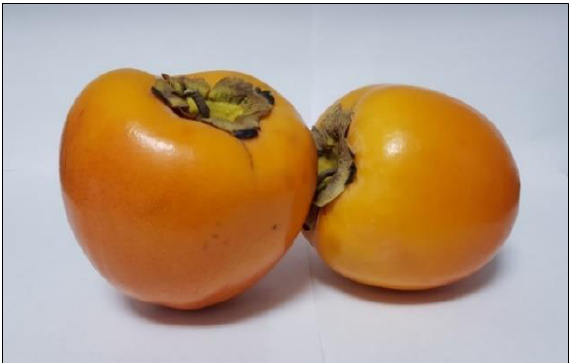
Figure 1. Rojo Brillante persimmon fruits ( Diospyros kaki L.), Protected Designation of Origin (PDO) ‘Ribera del Xúquer’ samples analyzed in the present study.